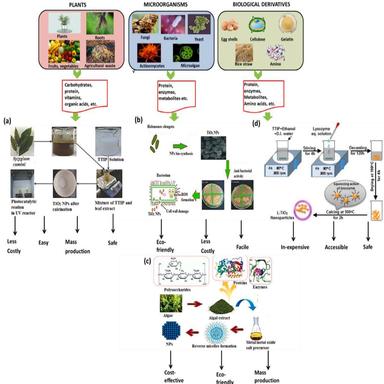
Advantages of green synthesis of TiO2 NPs by (a) Plant's extract (; (b) microorganism's (bacteria) extract); (c) microorganism's (fungus) extract and; (c) biological derivatives (.